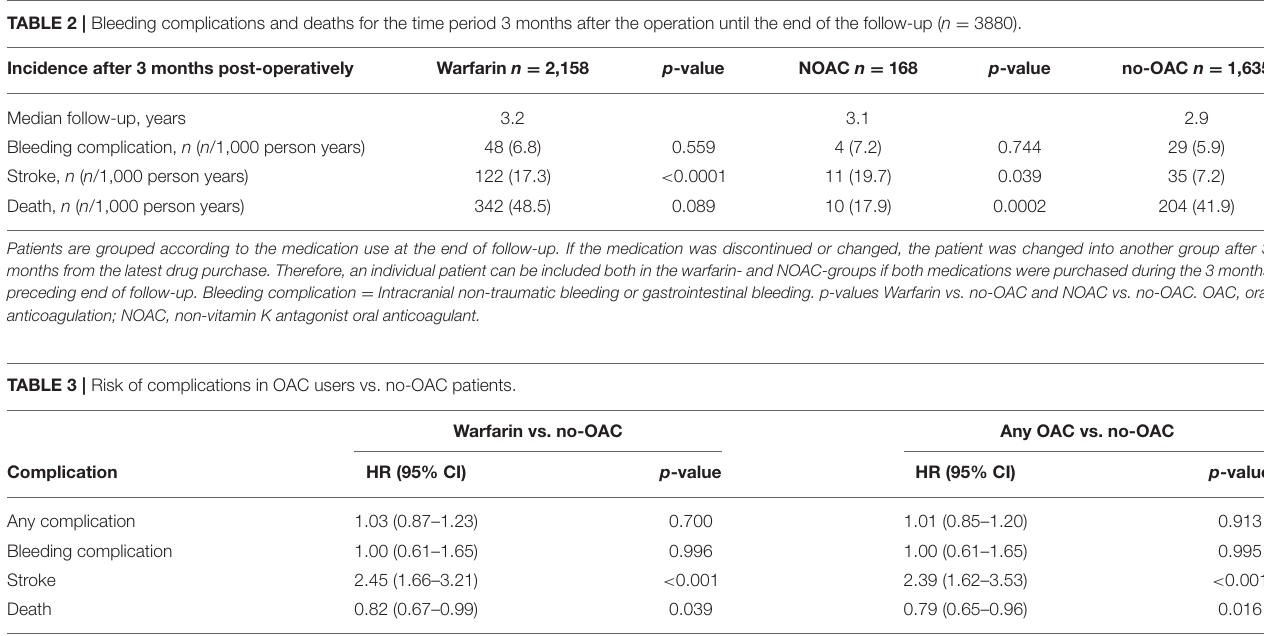
TABLE 2 | Bleeding complications and deaths for the time period 3 months after the operation until the end of the follow-up ( n = 3880).